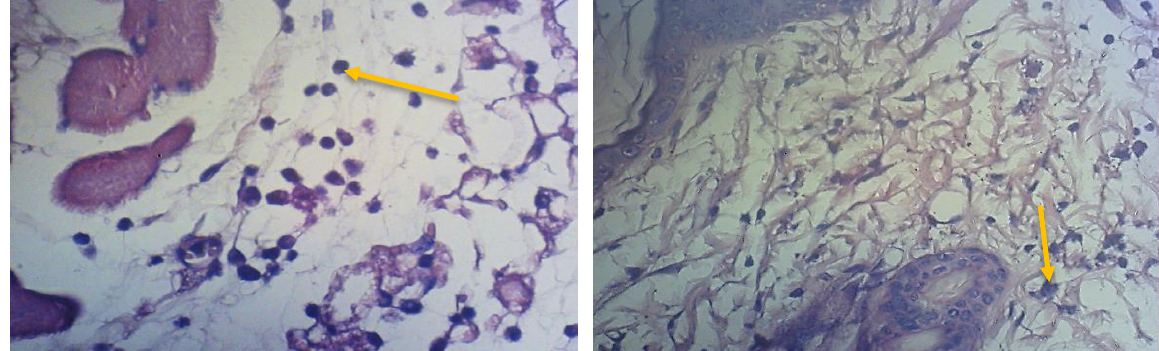
Figure, 7: Histological section show inflammation cell (Neutrophil) between muscle fiber. H&E stain 40X.